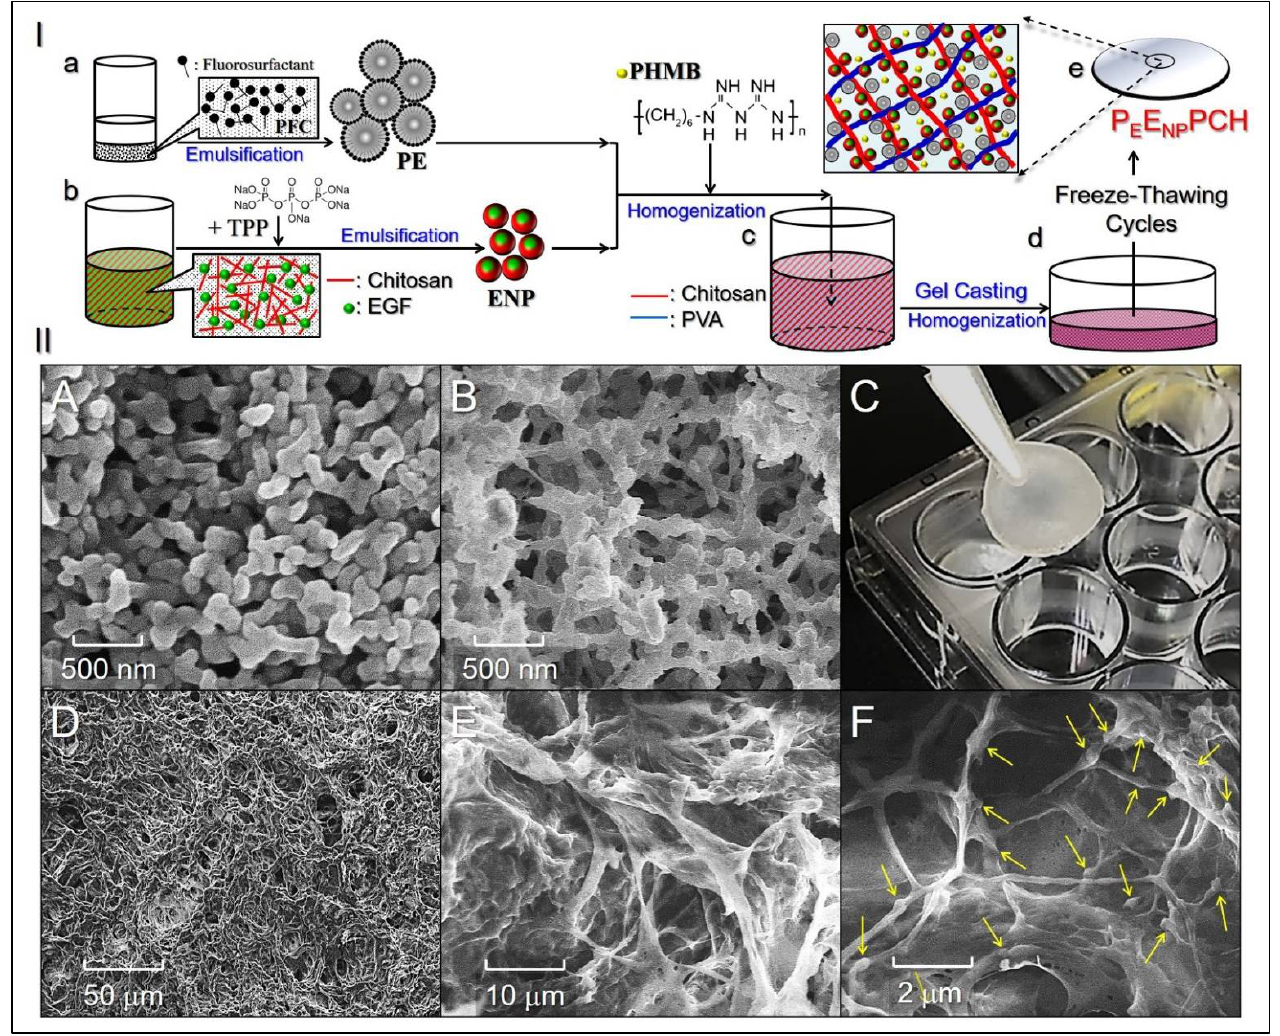
Figure 1. Analyses of the structure and morphology of the P E E NP PCH. ( I ) Schematic diagram of the P E E NP PCH fabrication procedures, including the manufacture of PEs and ENPs ( a , b ), hetero-composite hydrogel formulation ( c ), casting ( d ), and formation after eight freeze–thaw cycles ( e ). ( II ) Photomicrographic images of the manufactured nanoparticles and hetero-composite hydrogel. ( A , B ) SEM images of the ENPs ( A ) and PEs ( B ) at 50,000 × magnification. ( C ) Photograph of the